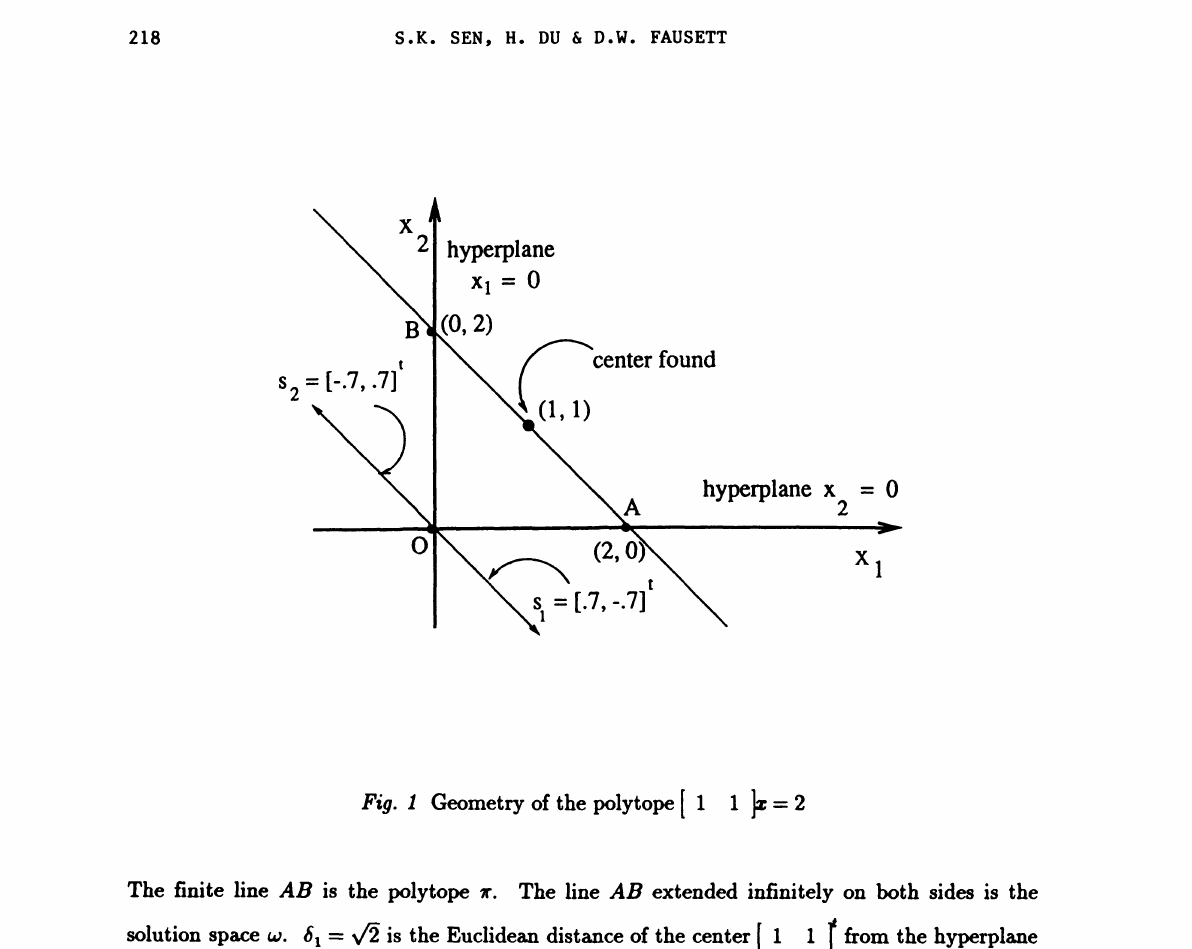
Fig. I Geometry of the polytope 1 1